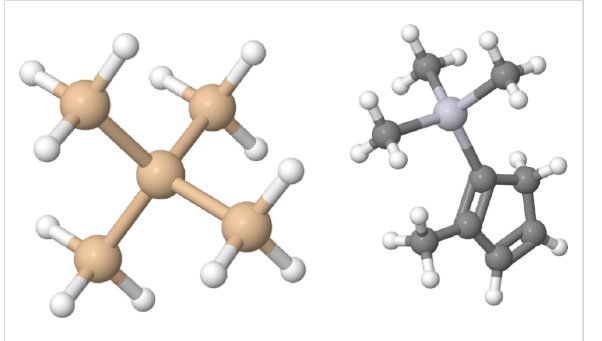
Figure 6: Elemental composition of various Pt–Si deposits as deter- mined by EDX according to [28]. The data were taken after sample growth without a break of the